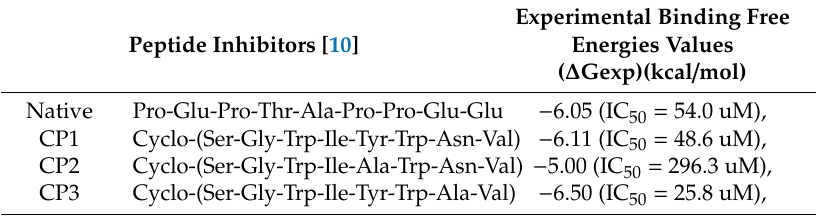
Table 1. Inhibitors of UEV